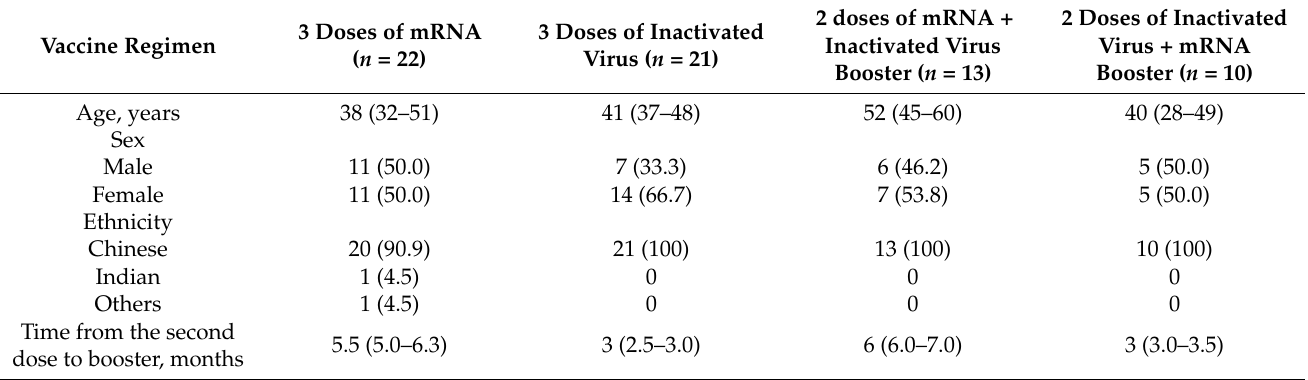
Table 1. Characteristics of study